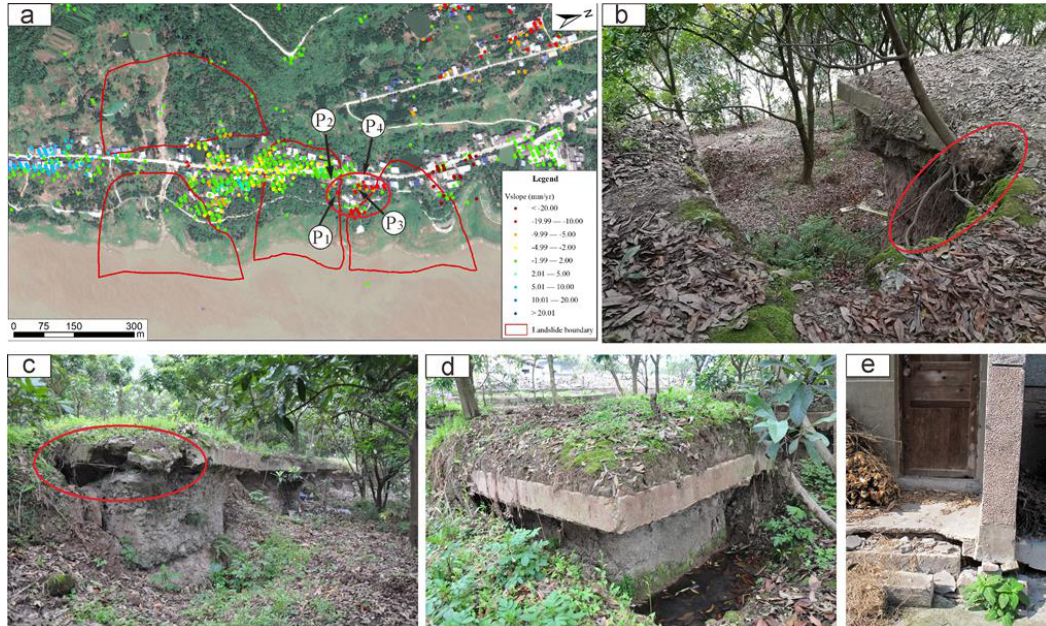
Figure 9. ( a ) The PSInSAR deformation rate map of the Dazhou landslide, with the strong deformation area circled in red. ( b ) The soil slip between the anti-slide piles observed at the circled area at site P1 (shown in a); ( c ) Damage to the anti-slide piles at the circled area at site P2 (shown in a ). ( d ) An anti-slide pile shifting towards the sliding direction at site P3 (shown in a ); ( e ). Crack observed in a nearby house at site P4 (shown in a